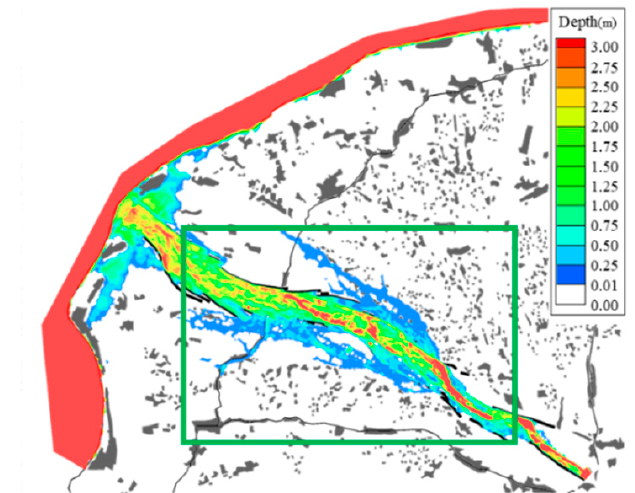
Figure 16. Inundation depth distribution Case (e): elapsed time = 41 h.